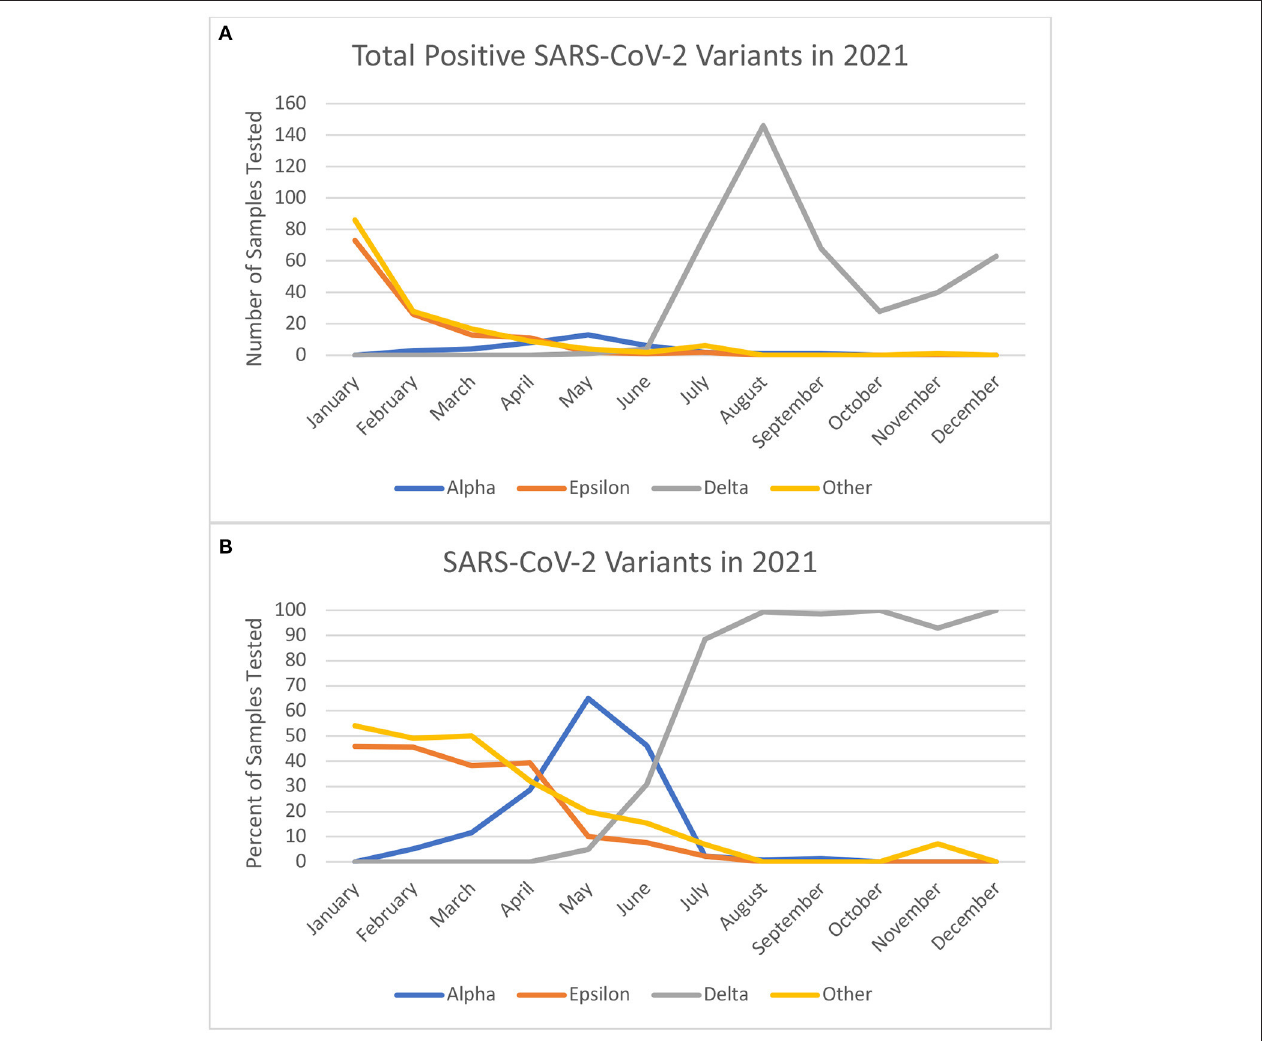
FIGURE 1 | (A) Shows the absolute number of samples tested at our center in 2021 by month and included in the study. (B) Shows the monthly percentages of variant types from the positive test. Of note December does not reflect the Omicron variant which was prominent in the final week of December